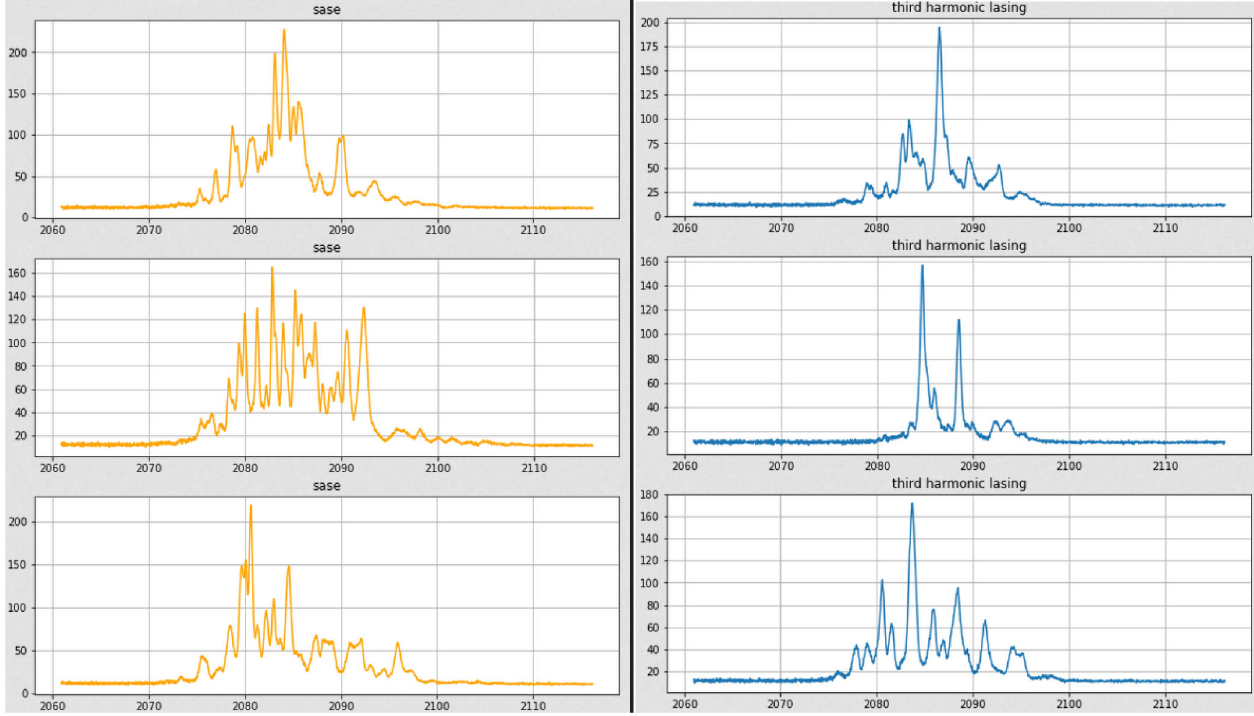
FIG. 4. Single-shot spectra for SASE (left column) and HLSS (right column). Plots show spectral intensity (in arbitrary units) versus photon energy (in eV). HLSS operates in “ 5 þ 7 segments ” configuration. One can see a reduction of number of spikes in the HLSS